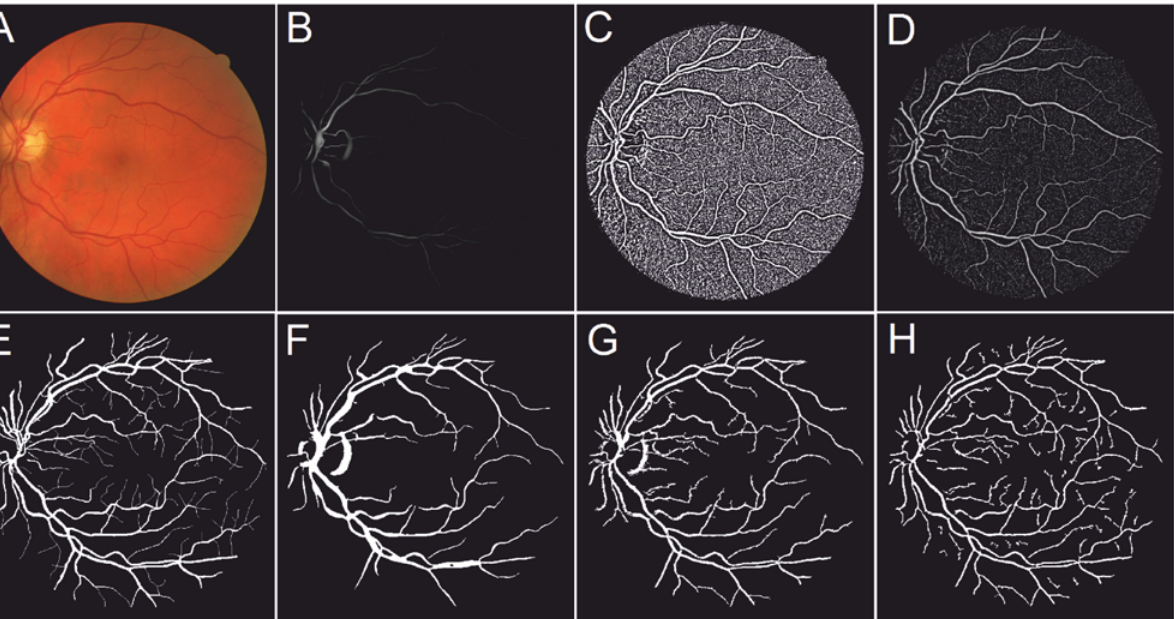
Fig 6. Illustrative enhancement results using different methods and their subsequent graph cut based segmentation results. (A) A randomly chosen image from the DRIVE dataset and expert ’ s annotation. (B)-(D) Eigenvalue-based (FR), wavelet-based (WL), and proposed local phase-based (LP) enhancements on (A). (E) Expert ’ s annotation. (F)-(G) Graph cut based segmentation results on